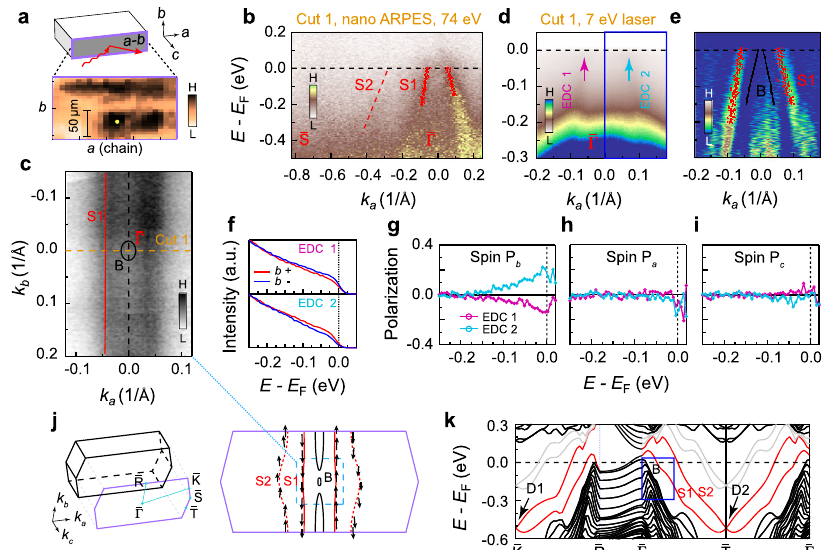
Fig. 2 Surface band of the side a-b surface. a Real-space photoemission intensity mapping from a synchrotron-based nano-ARPES. The width of the cleaved area with high intensities of photoelectrons is about 50 μ m. b Band structure from nano-ARPES with 74 eV photons at the position indicated by yellow solid dot in a . The red dots are duplicates of the ones in e , and the red-dashed line roughly indicates the band S2 in k . c Fermi surface measured from the a-b surface with laser-based ARPES. d Band structure of Cut 1 in c . The blue box corresponds to the one in k . e MDC curvature 38 plot of d . The red dots are extracted from the MDC peaks in d , and the black dots (band B) are duplicates of the black markers in Fig. 1h4. f Spin-resolved EDCs (along b direction) at EDC 1 and EDC 2 indicated in d , respectively. g – i Spin polarization curves along a , b and c directions at EDC 1 and EDC 2, respectively. More details on the spin data analysis can be found in Supplementary Fig. 4. j Projected surface BZ and Fermi surface from fi rst-principles slab calculations on the a-b surface. The black arrows indicate the in-plane spin direction. k Band structure from fi rst-principles slab calculations on the a-b surface. The red lines indicate the surface bands, while the black lines represent the bulk bands. Due to the presence of the broken bonds at the surface, two trivial bands colored in gray appear below E F in fi rst-principles slab calculations. They are not intrinsic and do not appear in the calculations based on Wannier functions 10,26 , of which the Fermi surfaces are not shown in j . The blue box corresponds to the one in d .